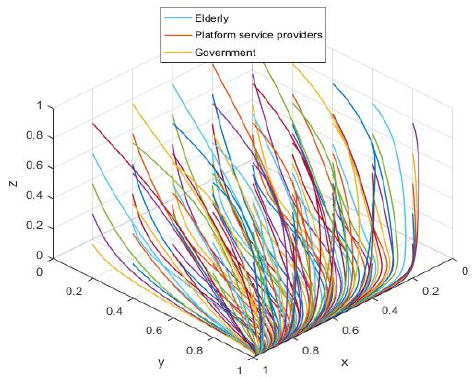
Table 4. Parameter assignment for